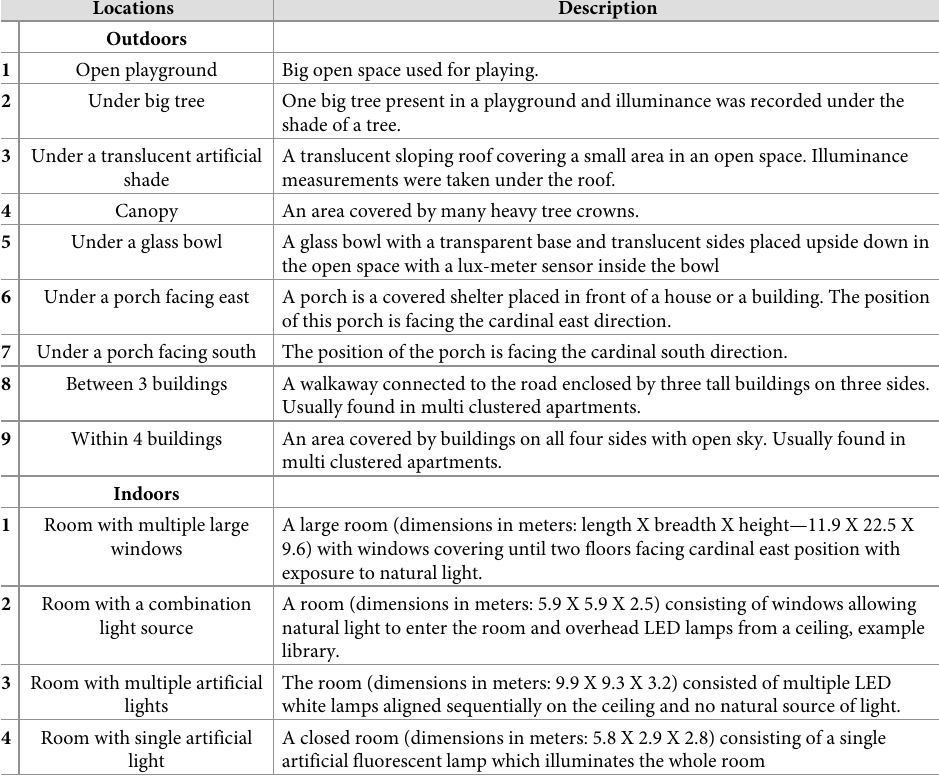
Table 1. List of nine outdoor and four indoor locations with their description. Pictorial presentation of these loca- tions are available in S1 File. Locations